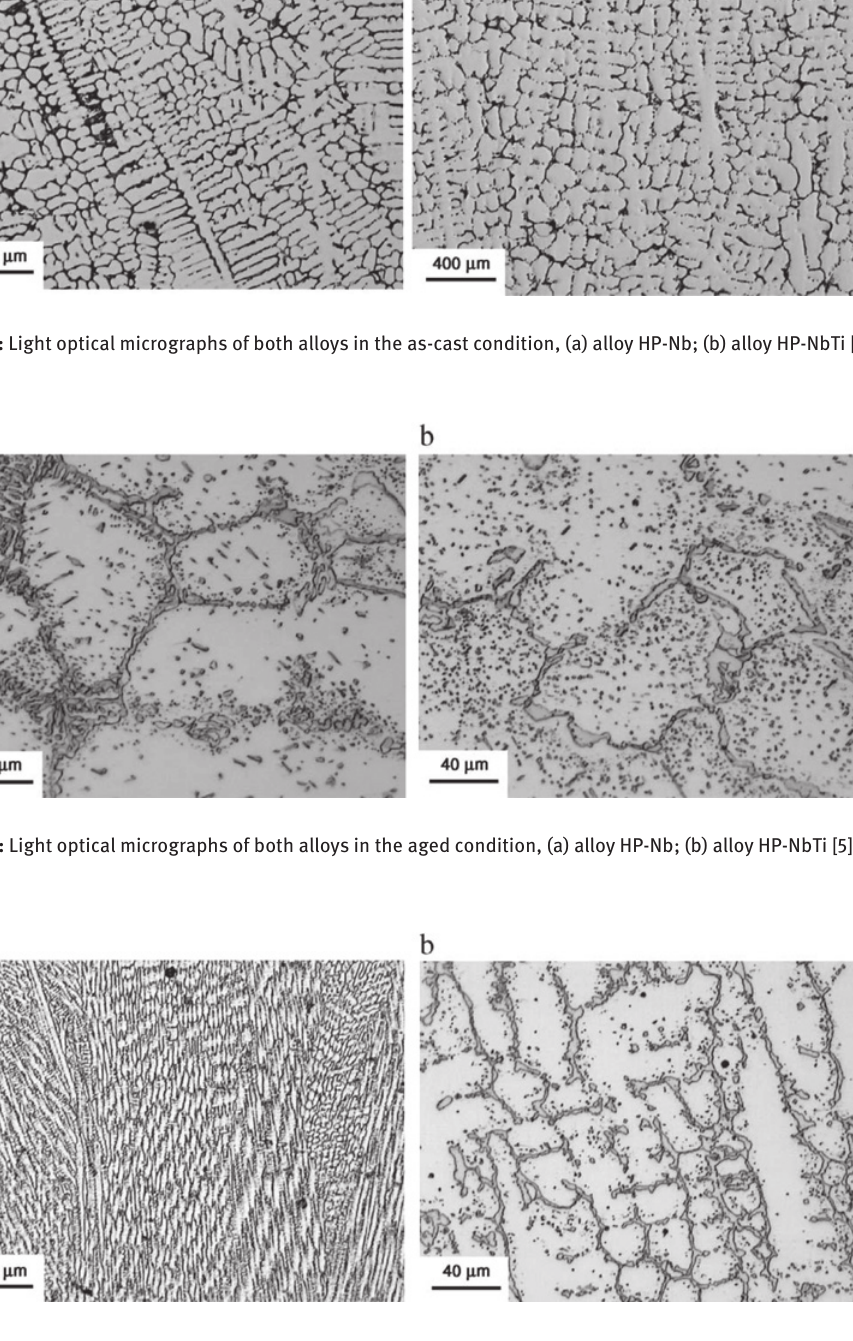
Fig. 5: Light optical micrographs at two different magnifications of weld metal in aged condition